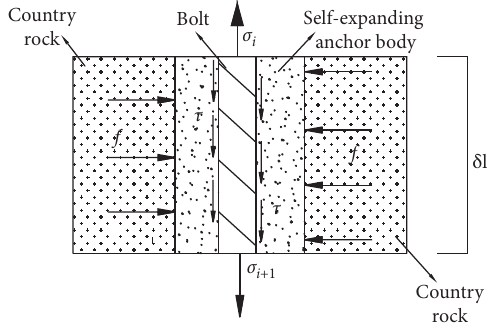
Figure 23: Schematic diagram of the axial force of the anchor